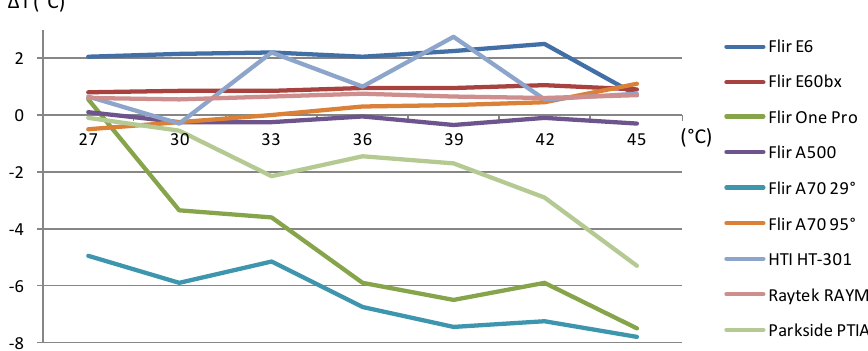
Figure 25. Graphical representation of deviation in °C from the reference value.